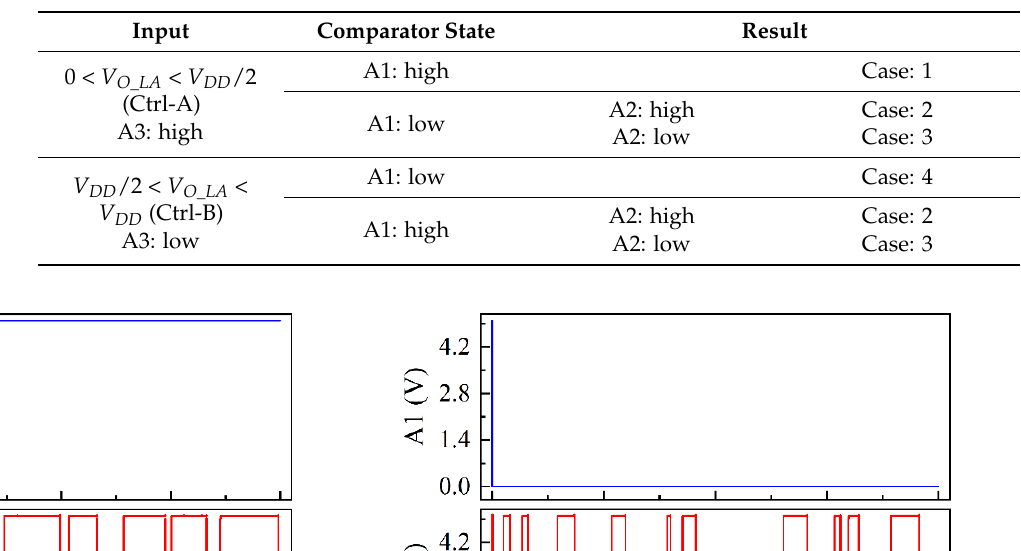
Figure 10. Circuit structure of the hysteretic control loop. Table 2. Operation of the control loop.